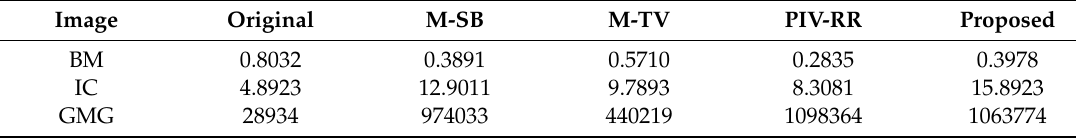
Figure 8. Sample image, restoration and reconstruction results: ( a ) sample image; ( b ) result of M − SB; ( c ) result of M − TV; ( d ) result of PIV − RR; ( e ) result of the proposed method in this paper. Table 6. Comparison of evaluation Table 8. Comparison of evaluation results.